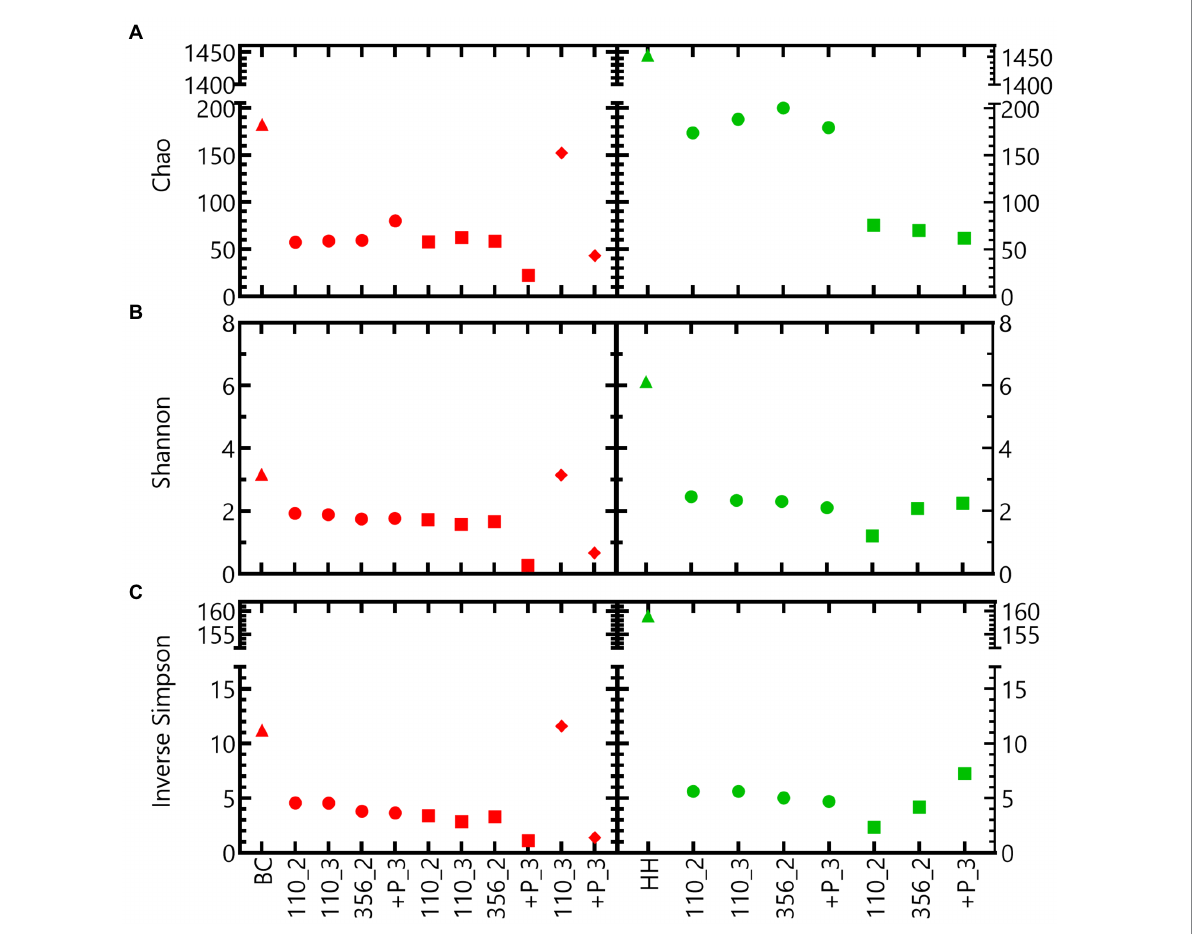
FIGURE 6 Alpha diversity indices ( (A) Chao, (B) Sannon and (C) Inverse Simpson index) of tests inoculated with Boom Clay borehole water (red) and Harpur Hill sediment (green) at initial pH 9 (circles), pH 10.5 (squares) and pH 12.5 (diamonds). The initial community is presented as